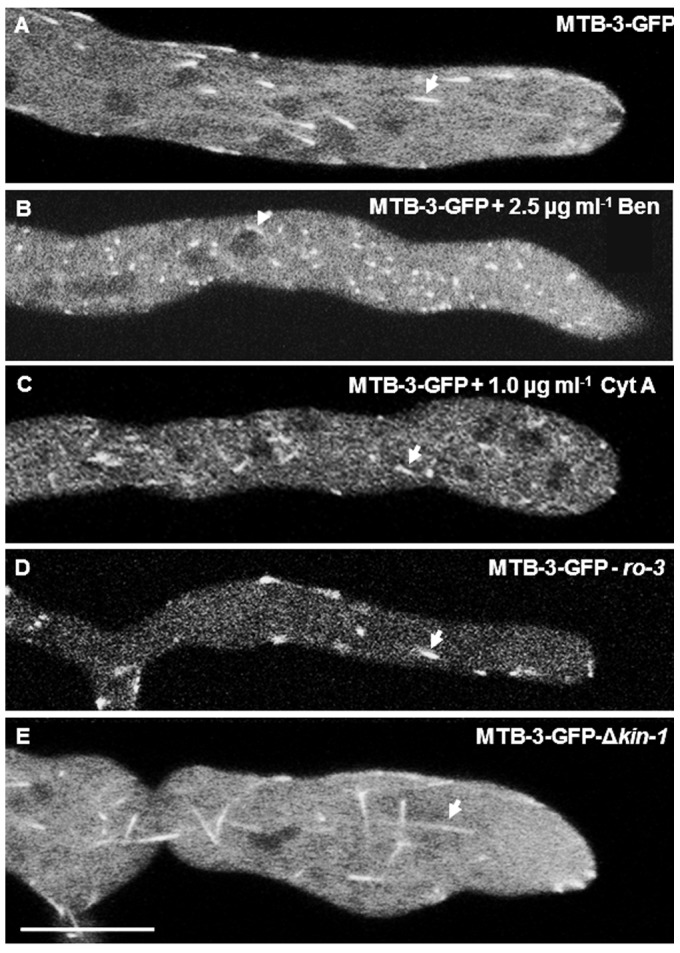
Effect of drugs anti MTs and actin and mutation of motor proteins in MTB-3-GFP comets.Effect of benomyl (Ben), cytochalasin A (CytA) or mutation of motor proteins (ro-3 and Δkin-1) on localization and dynamics of MTB-3-GFP comets. (A) MTB-3-GFP in the WT strain in untreated mature hypha, (B) MTB-3-GFP in mature hypha treated with 2.5 µg ml−1 of Ben to depolymerize MTs. (C) MTB-3-GFP in mature hypha treated with 1.0 µg ml−1 Cyt A, to disturb the actin cytoskeleton. (D) MTB-3-GFP in the dynactin mutant (p150glued subunit, ro-3) and (E) MTB-3-GFP in the conventional kinesin deletion mutant (Δkin-1). Arrows point to the MTB-3-GFP comets in each treatment and mutant. Scale bar = 10 µm.